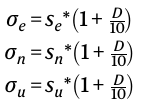
parameter ’ s variance-covariance matrix, given observation errors. The combination of ALOS, Sentinel-1, and GNSS data increases the redun- dancy and enables adjusting the observation errors 51 . Thus,